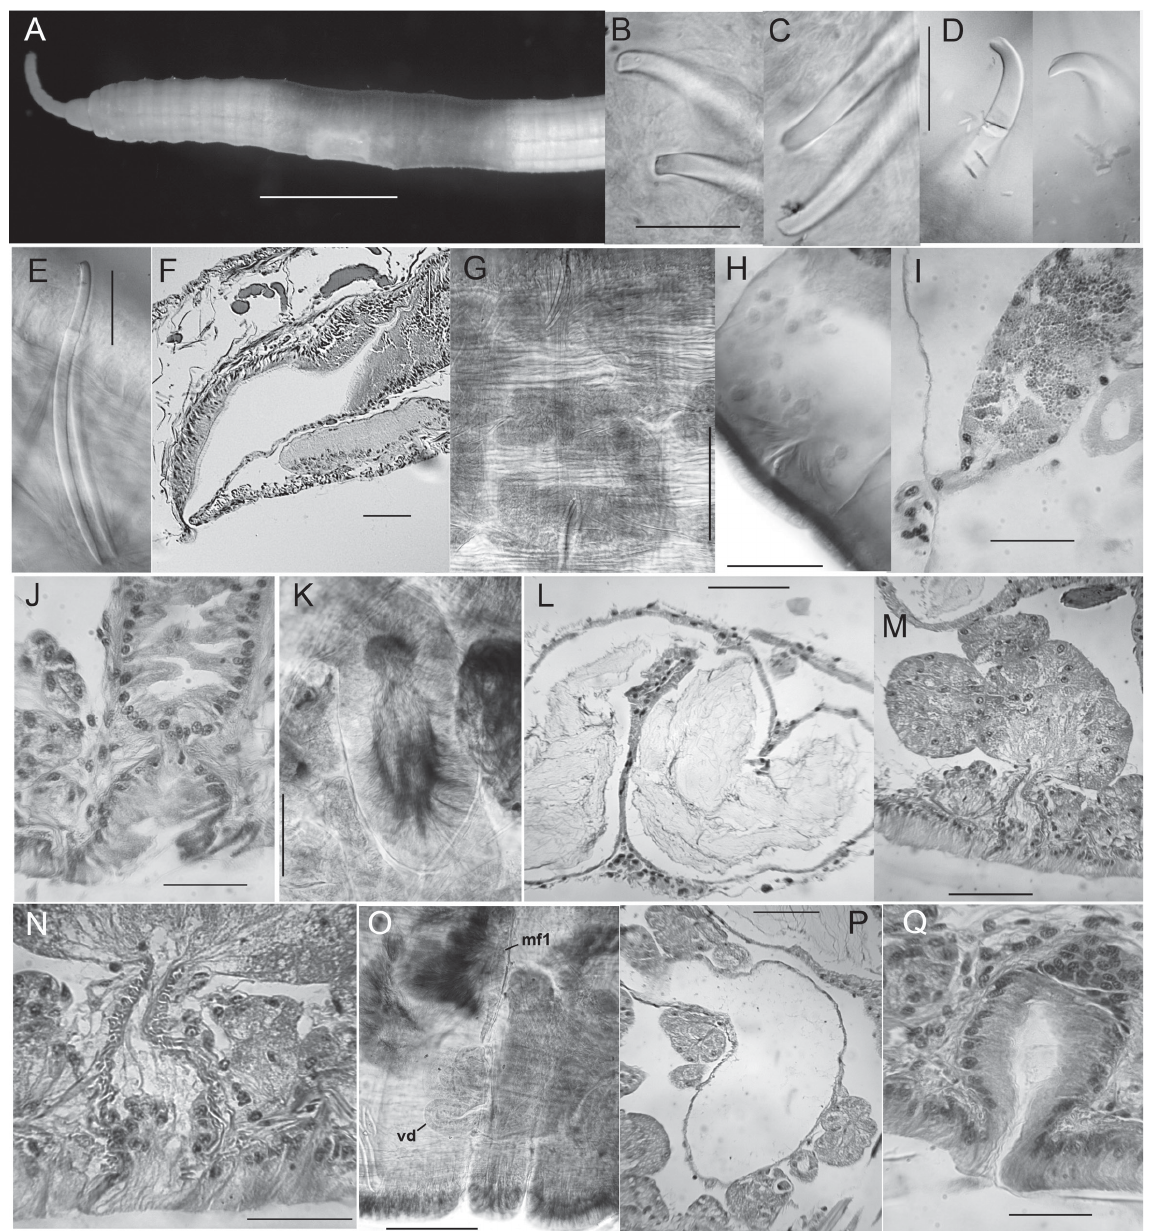
Fig. 9. Guestphalinus exilis Fend & Rodriguez sp. nov., from Squaw Creek (the type locality); F, I–N, P–Q from sagittal sections. A . A complete worm, anterior end, lightly stained with hematoxylin, showing clitellum and genital field. B . Tips of chaetae in II dorsal. C . Chaetae in II ventral. D . Tips of chaetae in two posterior segments, showing dorsal keel. E . Chaetae in II dorsal. F . Pharynx. G . Pharyngeal glands from a whole mount, 3 lobes facing anteriad (to left). H . Eleocytes, in a posterior segment. I . Nephridial funnel (left) and postseptal expansion. J . Spermathecal pore and constricted ectal end of duct. K . Spermathecal ampulla, ectal part, with sperm penetrating epithelium. L . Spermathecal ampulla, ental part with weakly-staining sperm. M . Ventral copulatory gland. N . Pore of copulatory gland. O . Anterior vas deferens protruding into VII (to left), with male funnel on 8/9. P . Expanded atrial ampulla with prostates. Q . Male pore. Scale bars: A = 2 mm; B–E, H–J, N, Q = 50 µm; F–G, K–M, O–P = 100